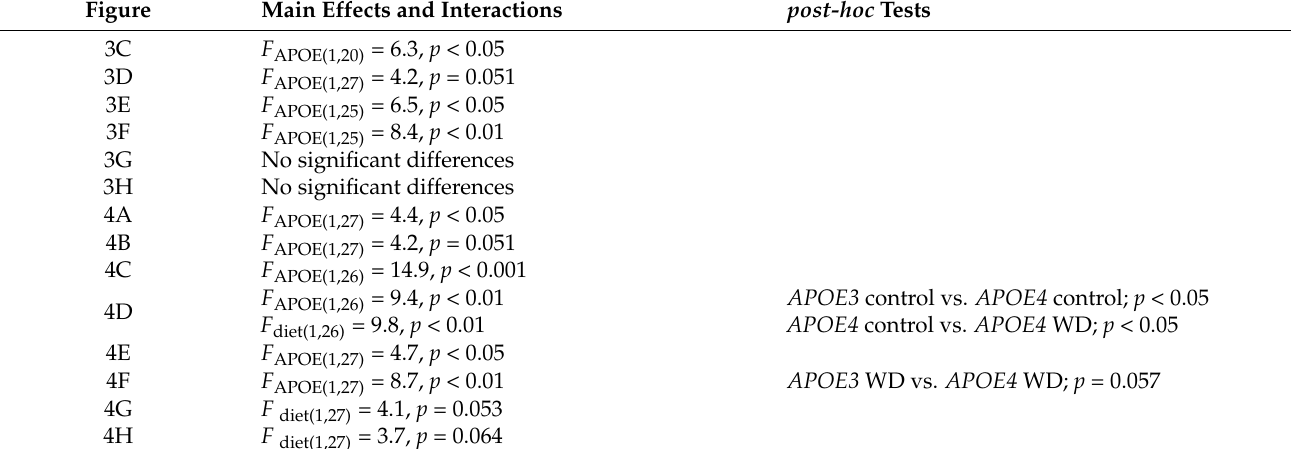
Figure Main Effects and Interactions post-hoc